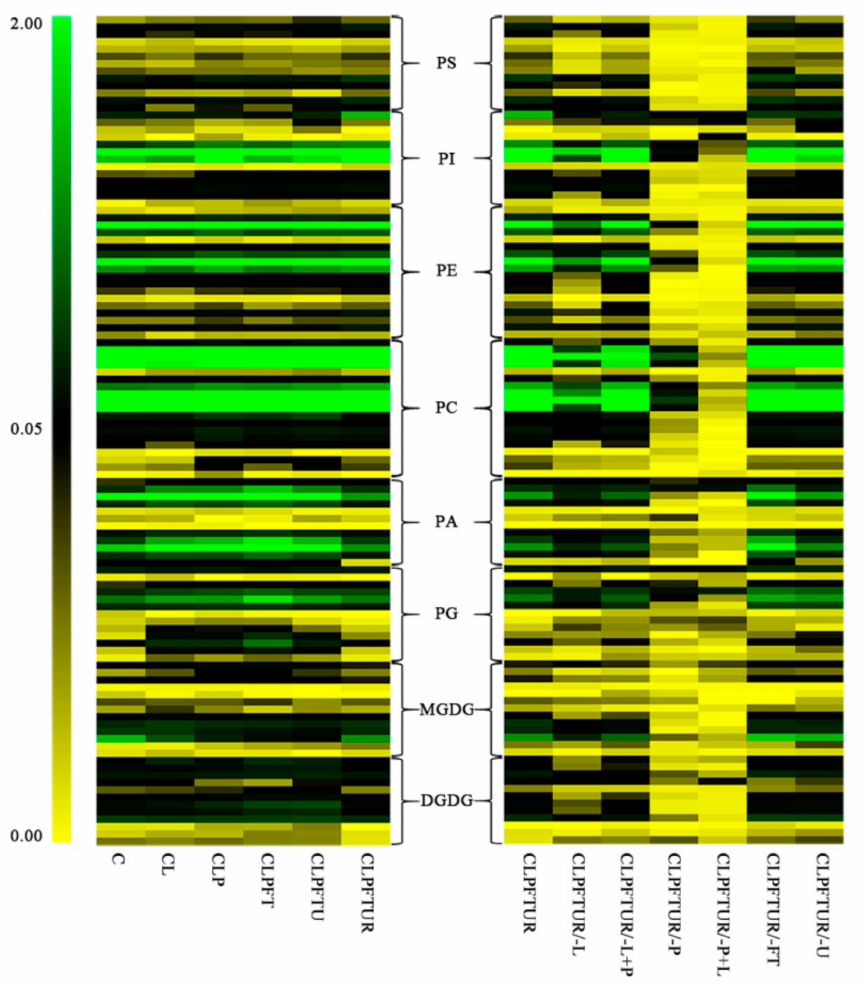
Figure 3. Effect of cryopreservation processes on the phospholipid profile of Magnolia officinalis embryogenic cell (ECs). Left panel: Standard-protocol cryopreservation. Right panel: Altered- protocol cryopreservation. Each colored bar within a column represents a lipid species in the indicated treatments (see Figure 1 legend for notation). The color of each bar represents the level of the corresponding lipid species (nmol/mg dry weight). A total of 113 lipid species in the indicated lipid classes are organized using class (as indicated), total acyl carbons (in ascending order within a class), and total double bonds (in ascending order within a class and total acyl carbons). The dry weight is the dry weight of tissue after lipid